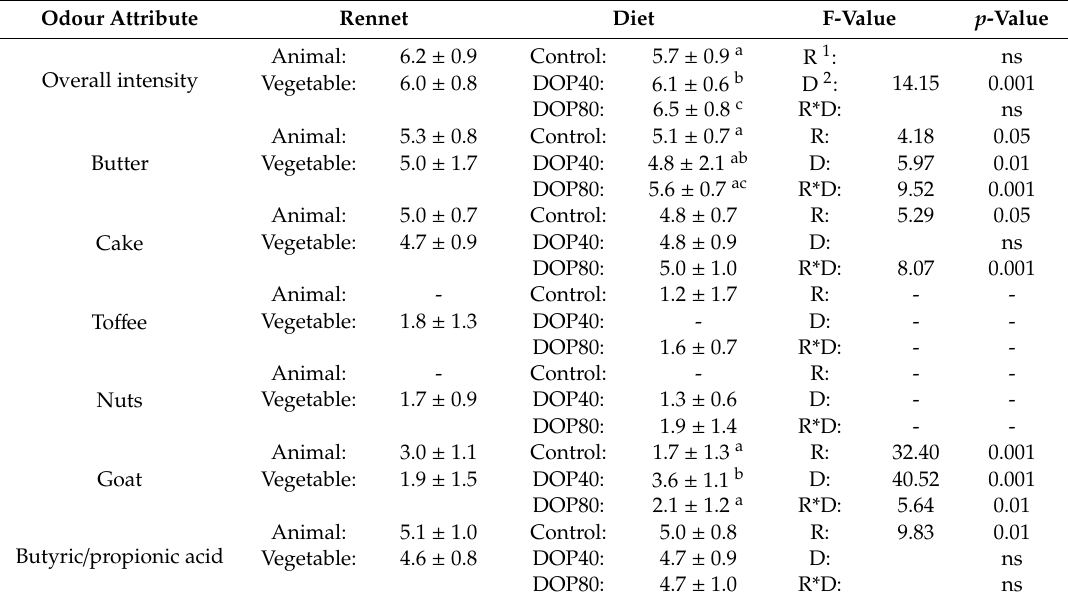
Table 3. Descriptive measures (mean and standard deviation) and analysis of variance (rennet × feeding) of odour attributes (F-value and probability